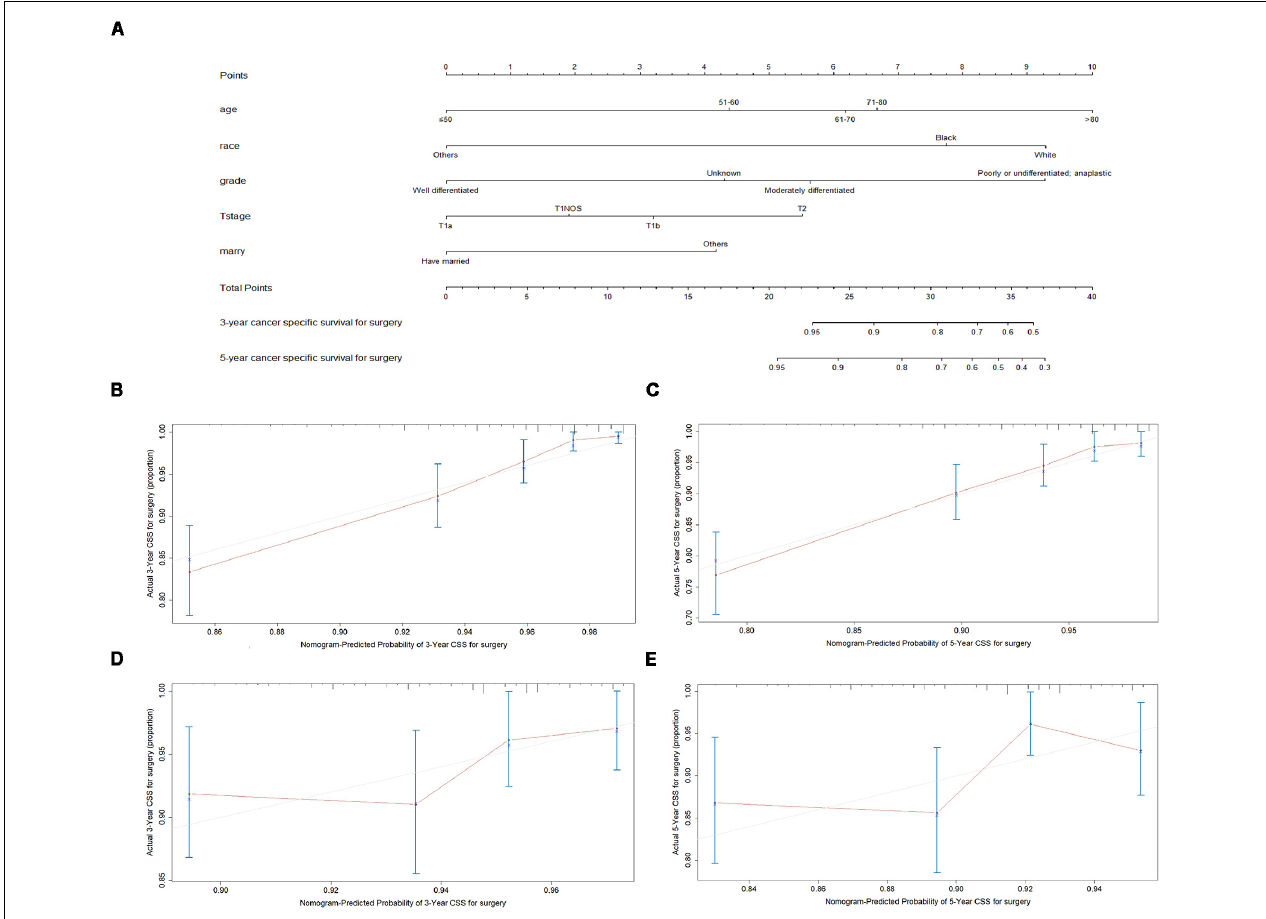
FIGURE 4 | Nomogram analyses for patients with surgery (A) A nomogram for prediction of 3- and 5-year CSS rates of patients (B) Calibration curve of the nomogram predicting 3-year CSS rates in training cohort. (C) Calibration curve of the nomogram predicting 5-year CSS rates in training cohort. (D) Calibration curve of the nomogram predicting 3-year CSS rates in validation cohort (E) Calibration curve of the nomogram predicting 3-year CSS rates in validation cohort.